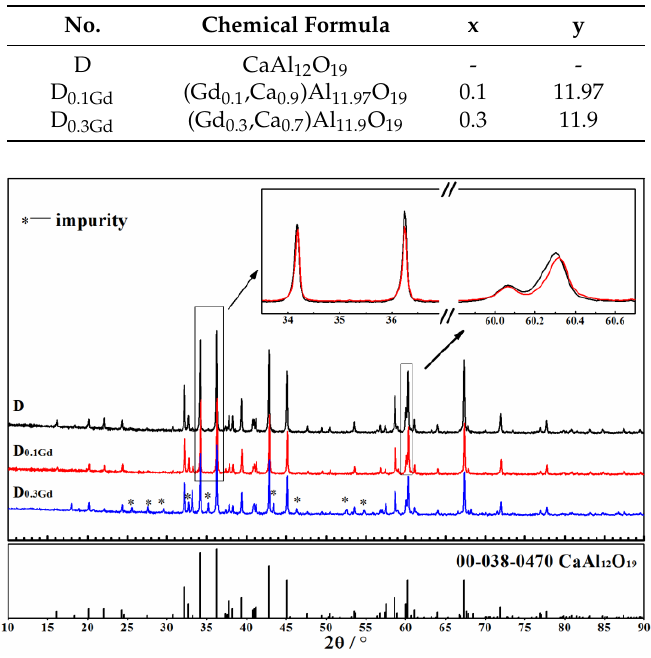
Table 1. Stoichiometric coefficient of (Gd x ,Ca 1 − x )Al y O 19.